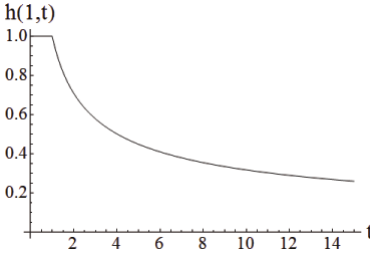
Figure 7. Graph of h (1 ,t ) plotted against drainage time t for 0 ≤ t ≤